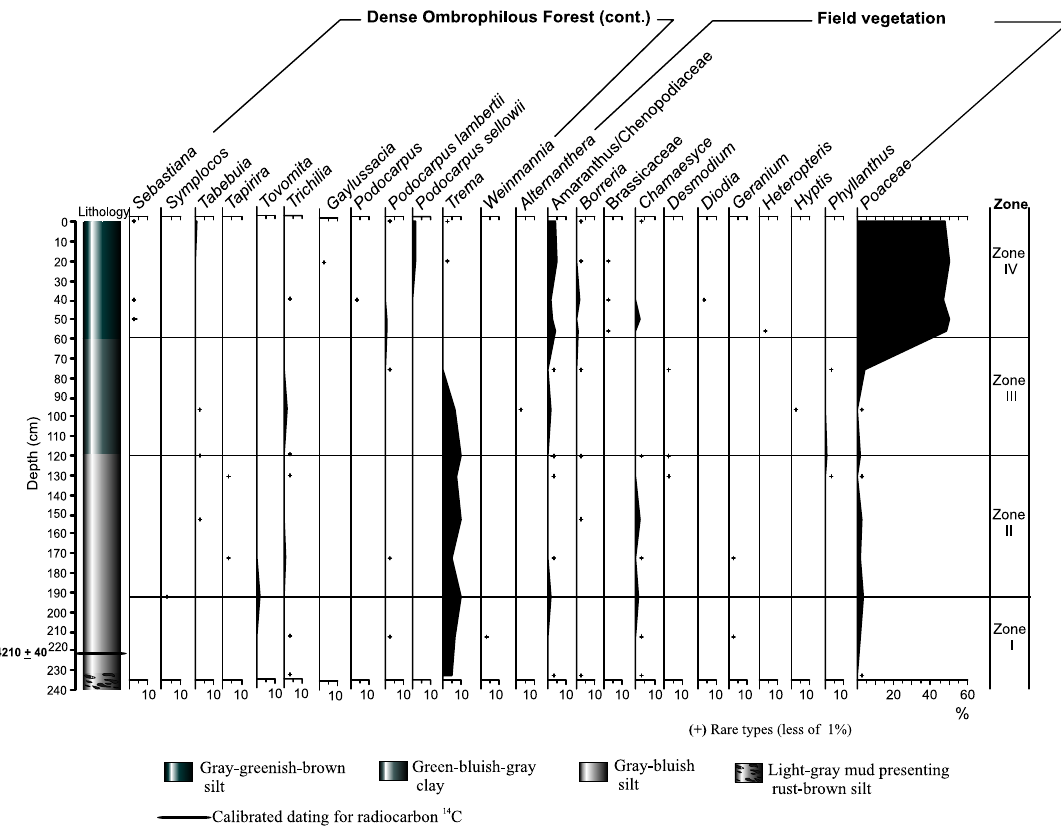
Fig. 5 – Percentage palynodiagram of pollen types grouped into Dense Ombrophilous Forest vegetation (cont.) and Field